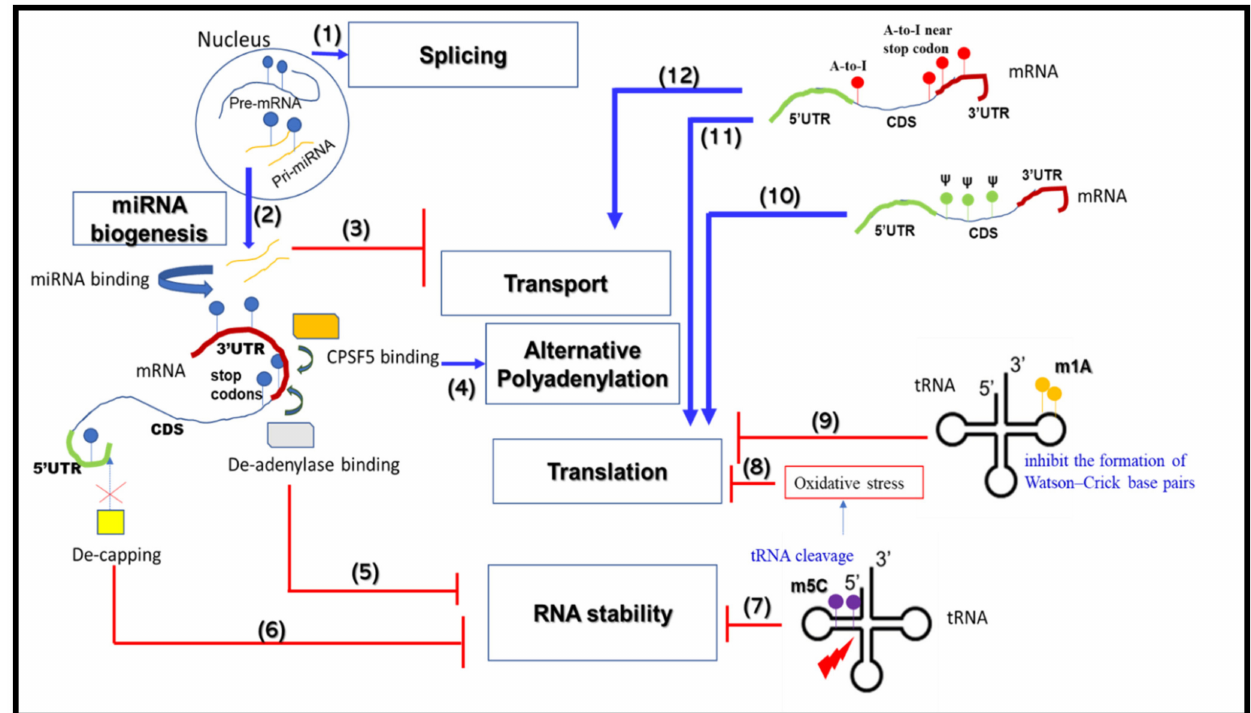
Figure 1. Illustrative model summarizing how various RNA metabolic processes are modulated by RNA modifications. Different RNA modifications, e.g., m6A, m5C, m1A, A-to-I RNA editing and pseudouridine, are represented by blue, purple, yellow, red and yellow colored pins, respectively. Various mechanisms of activation or inhibition of RNA metabolisms by RNA modifications are represented by ( 1 ) to ( 12 ), e.g., m6A modifications of pre-mRNAs ( 1 ) and miRNAs ( 2 ) facilitate splicing and miRNA biogenesis, respectively. The model shows that m6A modification of the 3 (cid:48) -UTR of mRNAs facilitates binding of miRNAs to this region and inhibits mRNA transport/translation ( 3 ). VERMA-mediated m6A modification near the 3 (cid:48) -UTR and stop codons of mRNAs facilitates alternative polyadenylation ( 4 ). Alternatively, m6A modification near the 3 (cid:48) -UTR and stop codons causes de-adenylase binding, thereby impairing stability ( 5 ). De-capping at the 5 (cid:48) -cap site with nearby m6A inhibits translation initiation and also reduces mRNA stability as a result of endonuclease activity ( 6 ). m5C modification of tRNAs induces their cleavage, thus altering RNA stability ( 7 ). Accumulations of cleaved tRNA fragments induce oxidative stress, which inhibits cellular translation ( 8 ). m1A modification impairs base pairing of tRNA-anticodons with the mRNA initiation codon, inhibiting translation initiation ( 9 ). Both A-to-I editing and pseudouridine modification alter start or stop codons of mRNAs, blocking mRNA transport/translation ( 10 , 11 , 12